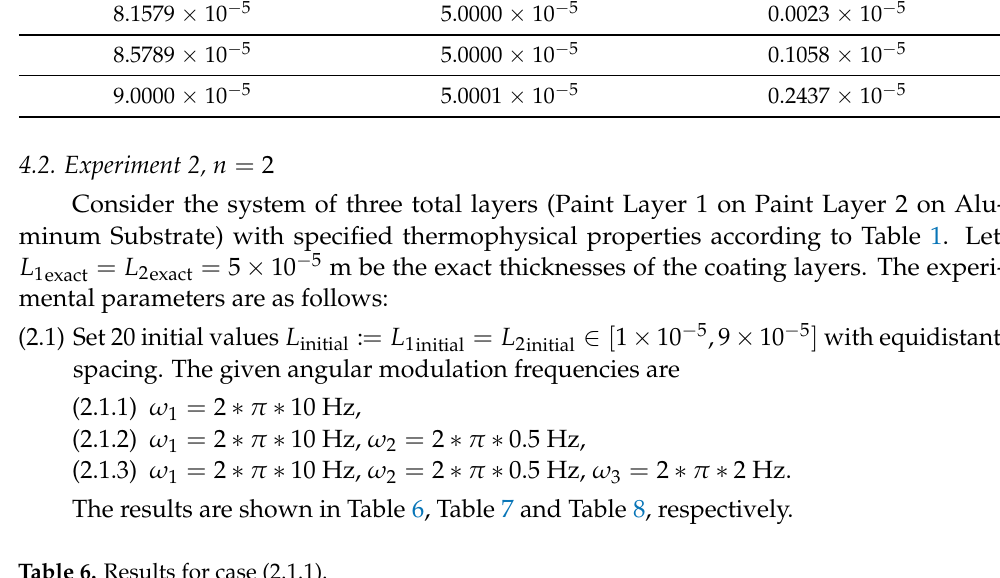
Table 6. Results for case